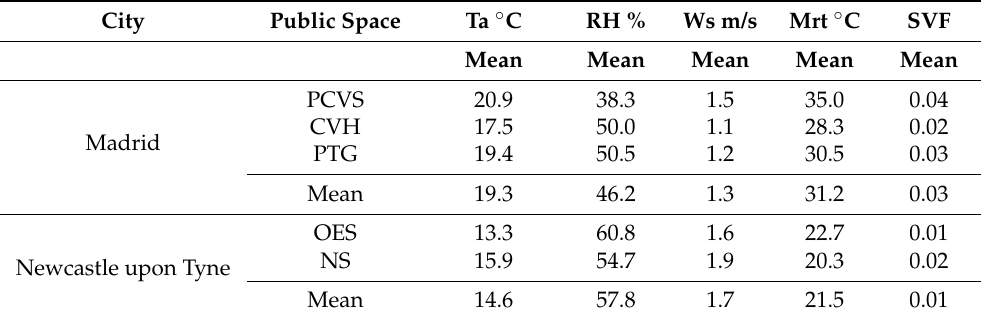
Table 2. Summary of environmental data measured in situ in public spaces in Madrid and Newcastle upon Tyne. City Public